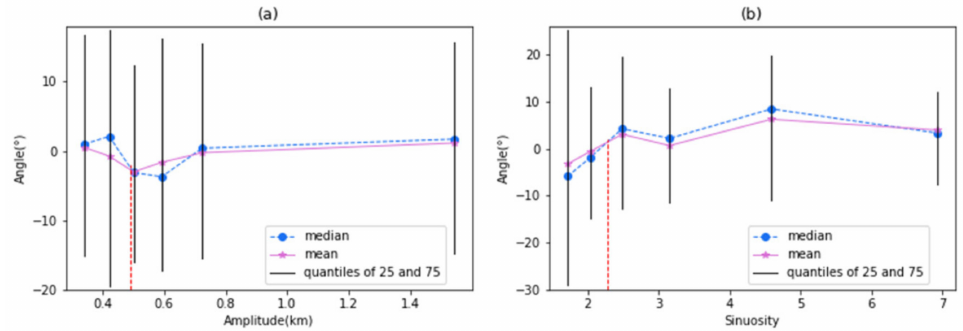
Figure 8. The skewing angle changes with amplitude and sinuosity. ( a ) the skewing angle changes with different amplitude, ( b ) the distribution of skewing direction under different